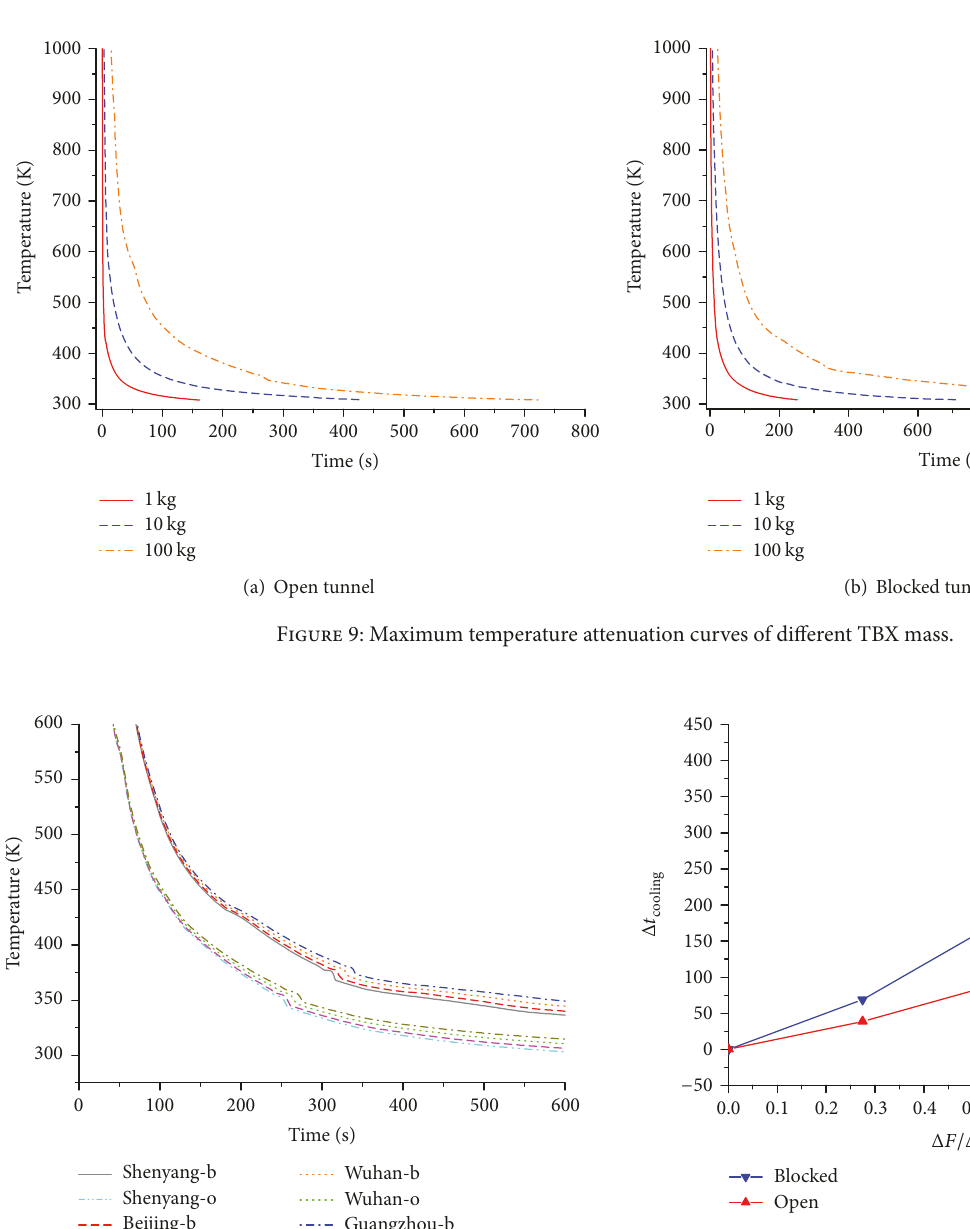
Figure 11: Cooling time changes against initial ground